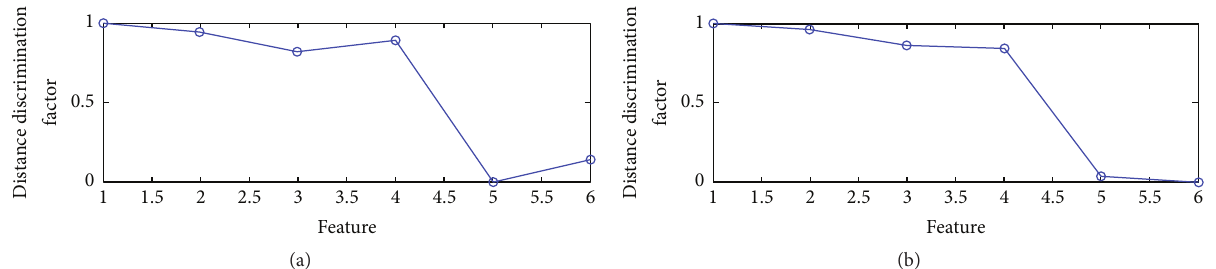
Figure 10: The distance discriminant factors of the six features (a) produced by the distance discriminant technique and (b) produced by the modified distance discriminant technique.